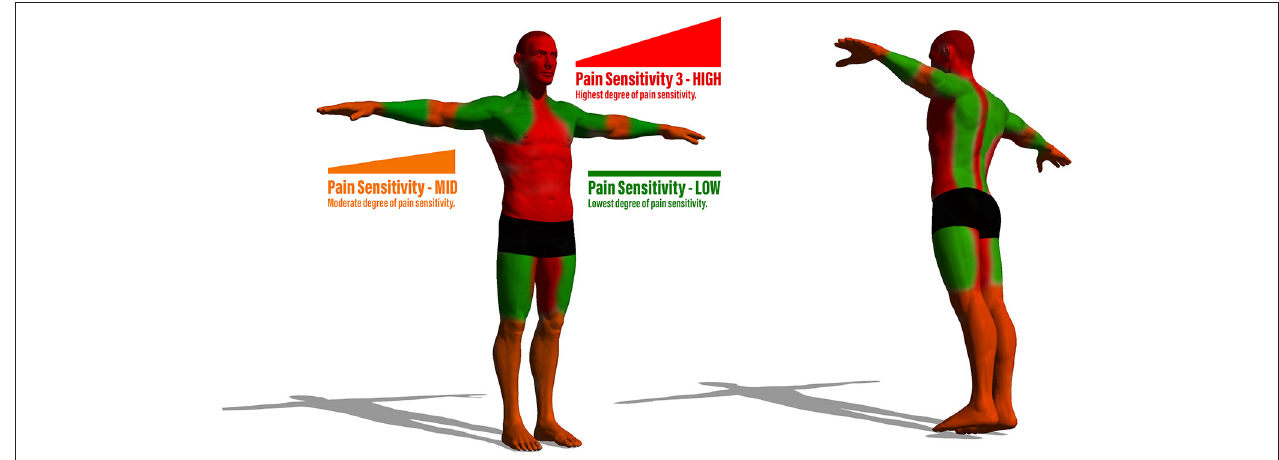
FIGURE 1 | Visualization of the two experimental conditions wherein the VH either responded or ignored an event occurrence during the